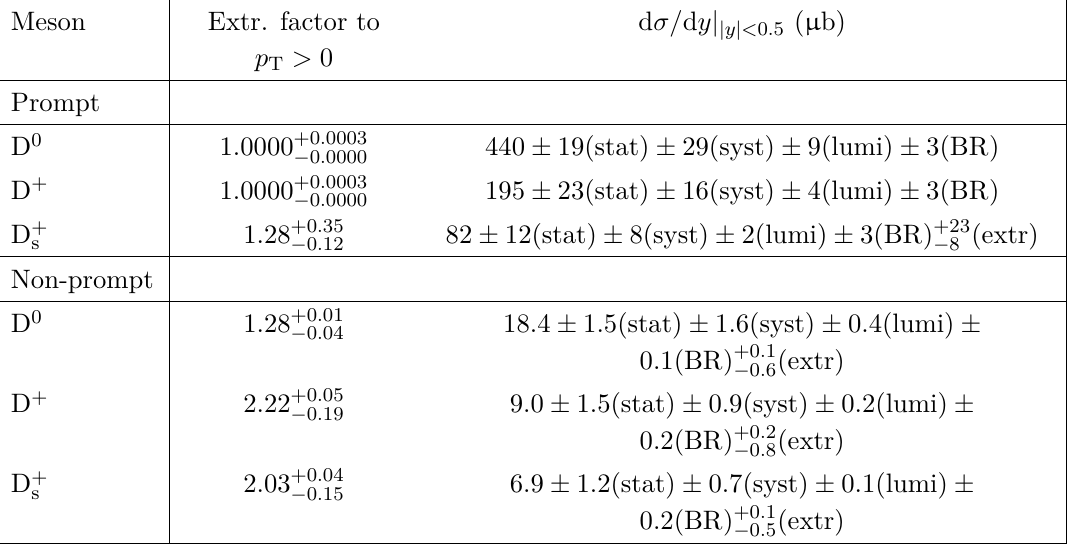
Table 4 . Production cross sections of prompt and non-prompt D mesons in the range | y | < 0 . 5 in √ pp collisions at s = 5 . 02 TeV